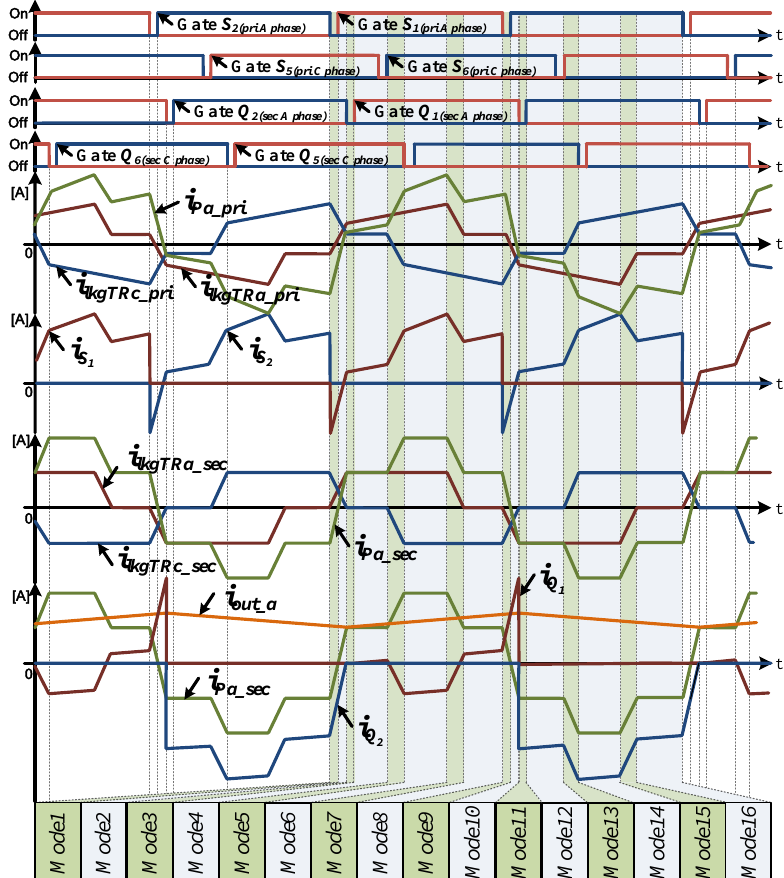
Figure 5. Configuration of the mode in accordance with the primary and secondary side switching state using the proposed phase shifting technique.